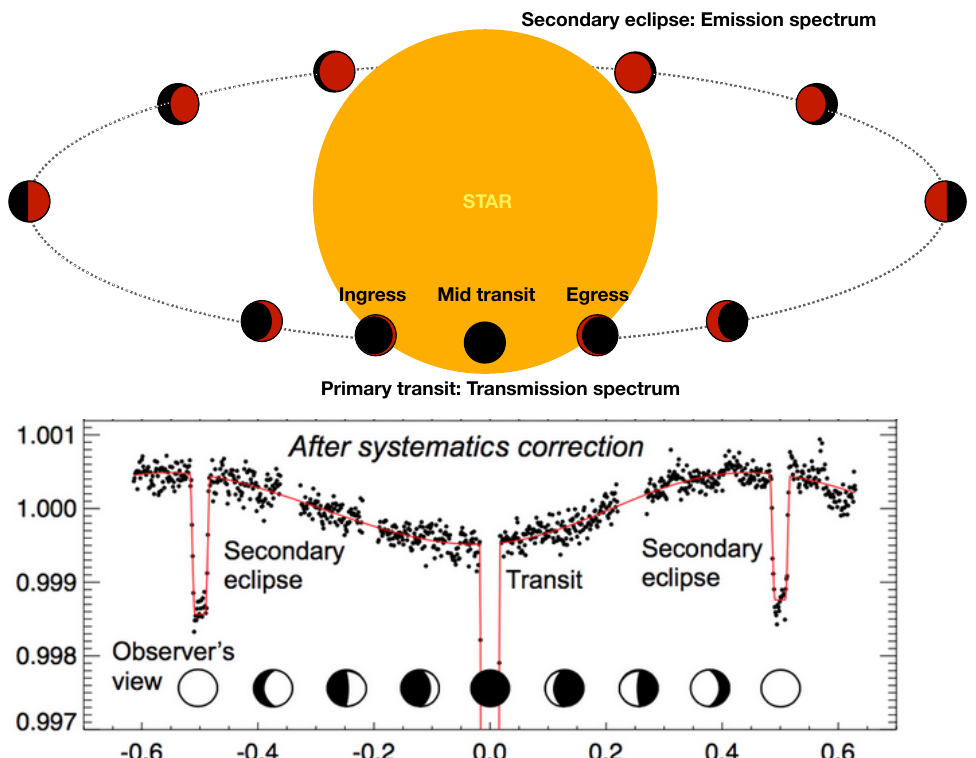
Figure 2. ( Top ) An example of the transiting phase curve of the hot Jupiter HD189733 b observed at 4.5 micron with IRAC/Spitzer. During the primary transit, the limbs of the atmosphere are probed just before the secondary eclipse on the day side of the planet is seen. ( Bottom ) Scheme of a transiting exoplanet around its star. The color bar of the planet highlights the day side of the planet (red) and its night side (black). Figure adapted from